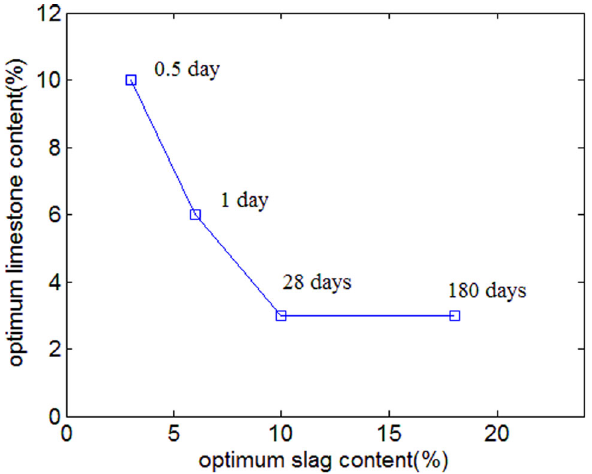
Fig. 12 Optimum percentages of limestone and